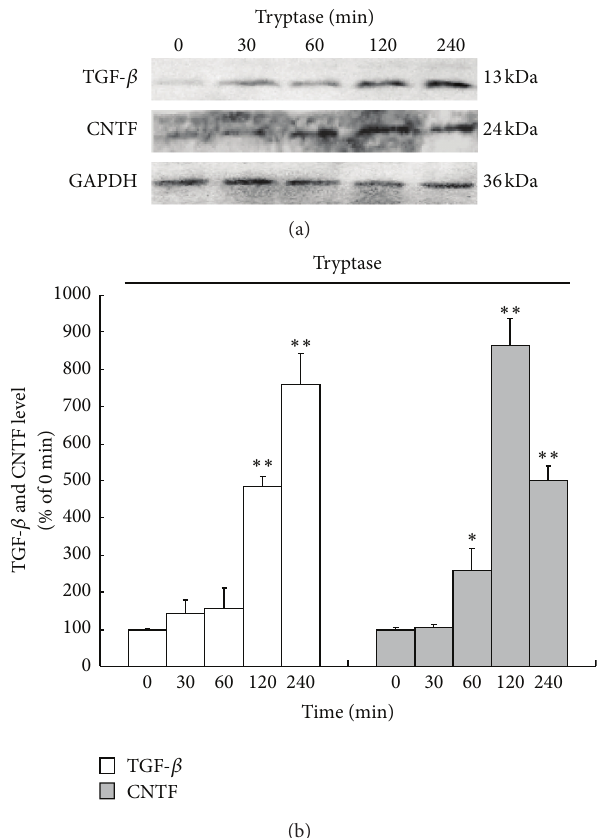
Figure 6: Time courses of tryptase (Tt) on the expression of transforming growth factor- 𝛽 (TGF- 𝛽 ) and ciliary neurotrophic factor (CNTF) in astrocytes. (a) Tryptase at 1 𝜇 g/mL was incubated with astrocytes at 37 ∘ C for 0, 30, 60, 120, and 240 min, respectively. Protein levels were detected by immunoblot analysis with specific antibodies. Western blots at the top of each panel are from a typical experiment. (b) Bar graphs are the quantified results expressed as mean ± SEM of TGF- 𝛽 and CNTF levels from three independent experiments. ∗∗ 𝑃 < 0.01 , ∗ 𝑃 < 0.05 versus